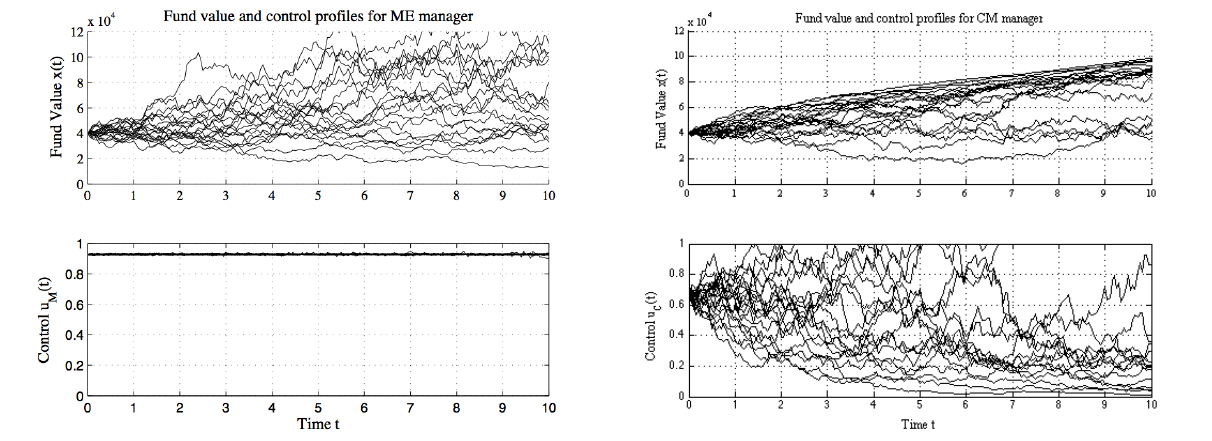
Figure 3. Fund value and strategy realisations.